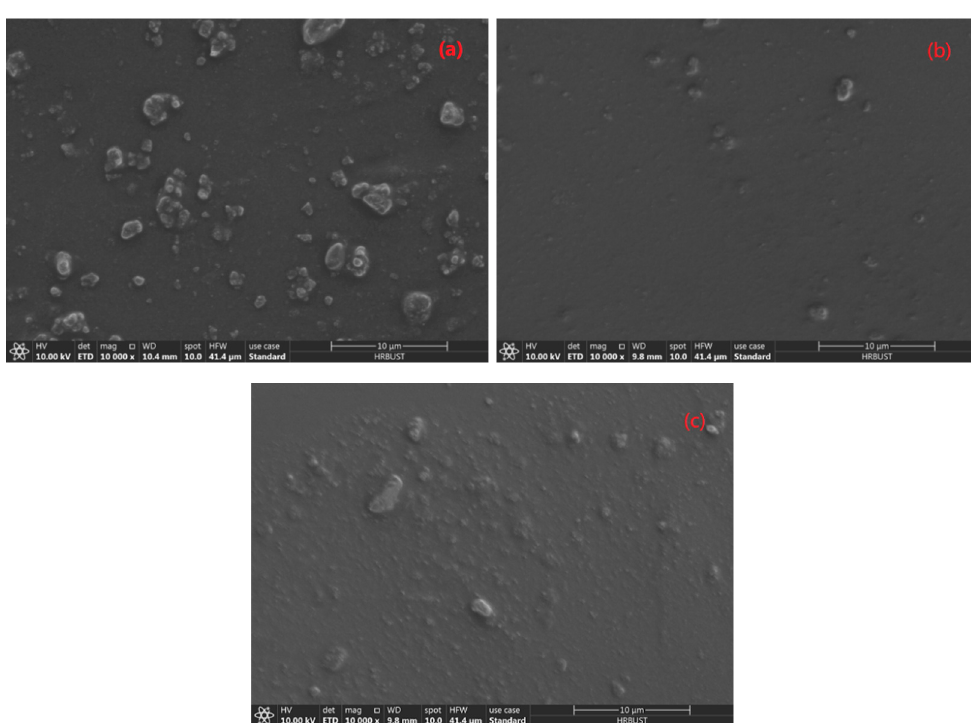
Figure 9. Cross-sectional SEM photos of PDMS composites doped with different silane coupling agents modified CCTO particles: ( a ) KH550-CCTO/PDMS; ( b ) KH560-CCTO/PDMS; ( c ) KH570- CCTO/PDMS.